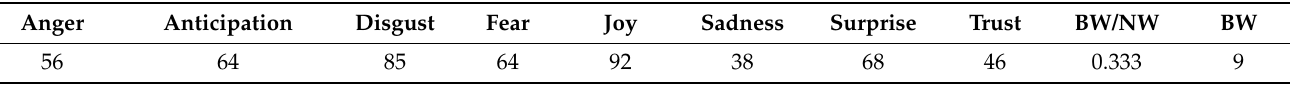
Table 5. Example feature vector Lexicon approach.